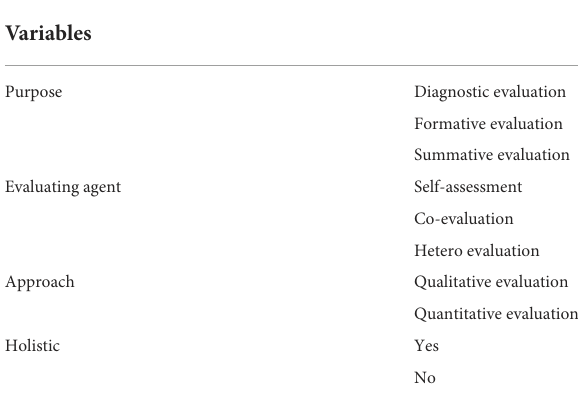
TABLE 3 Analyzed